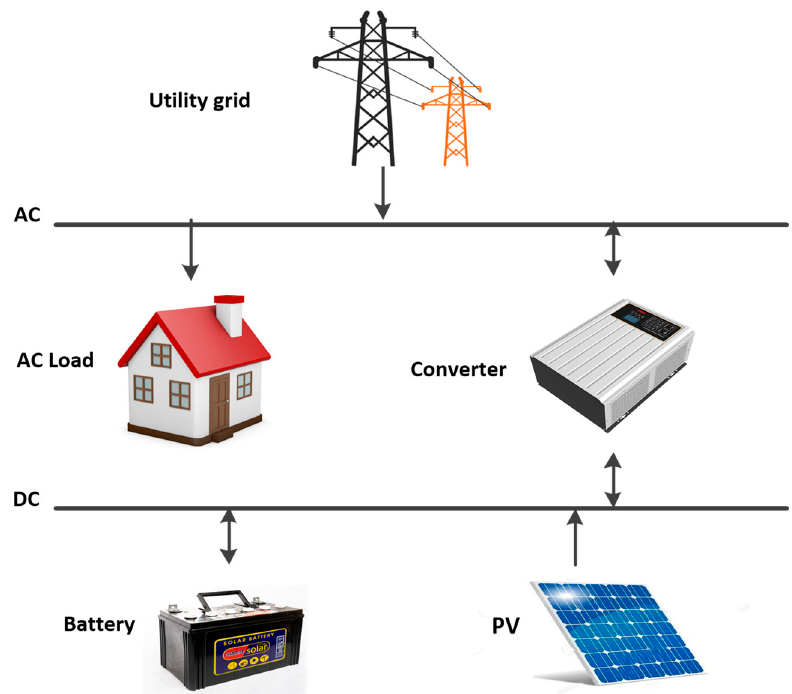
Figure 6. Configuration of the proposed HES. Table 1. Technical characteristics of the HES components.